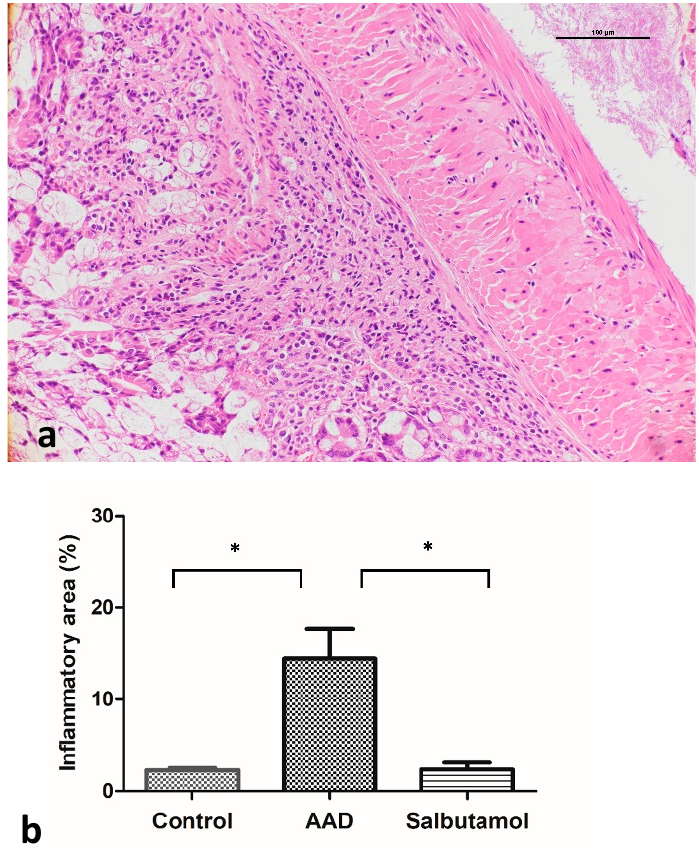
Figure 2. Microscopic analysis of the colonic mucosa. ( a ) Histological analysis of intestinal mucosa of ovalbumin (OVA)-challenged mice after hematoxylin and eosin staining (200 × ). Representative images depict inflammatory lesions in the intestinal mucosa. Erosions of the intestinal epithelia and infiltration of lymphocytes and neutrophils in the lamina propria and submucosa were observed. ( b ) The calculated area of the intestinal mucosa where inflammatory cells infiltrated was compared to the total mucosal area of the sample. The percentage of inflammatory area was compared among the groups. * p < 0.05.